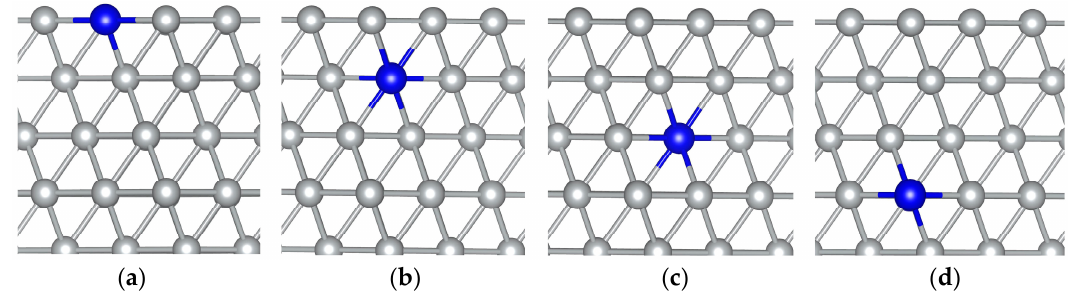
Figure 1. MoNi(111) alloy systems showing one Mo monomer substituting one Ni atom in the ( a ) first; ( b ) second; ( c ) third; and ( d ) fourth nickel layer. Only the four top layers are shown. Gray and blue balls represent Ni and Mo atoms, respectively.